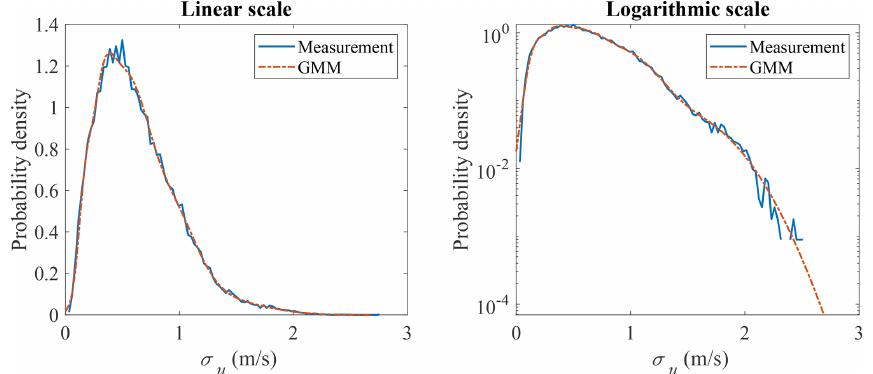
Figure 16. GMM marginal distribution of u for the onshore sector.